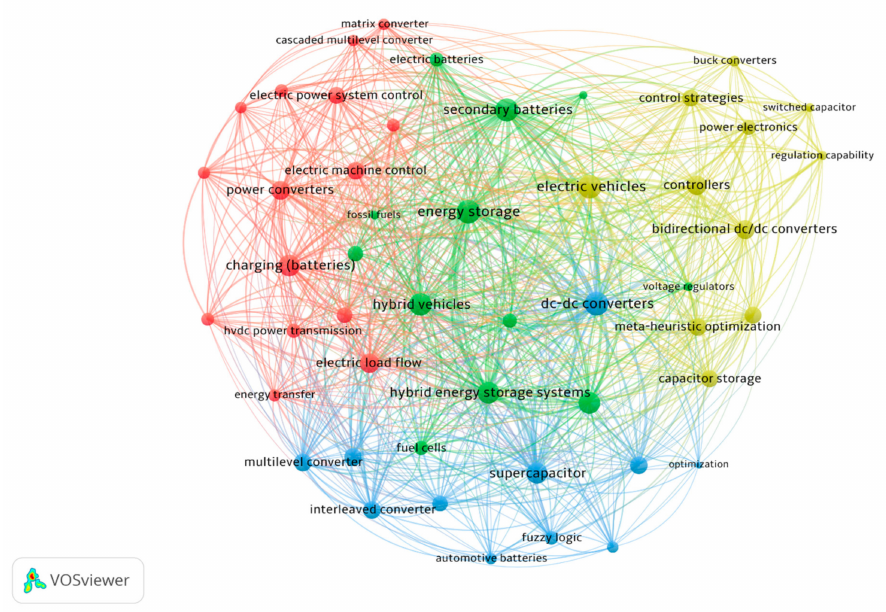
Figure 5. VOSviewer visualization for the analysis of co-occurrence keywords based on the Scopus database.